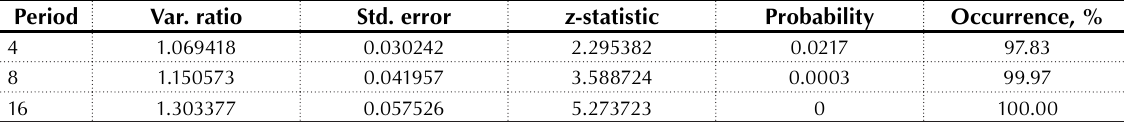
Table 4. Individual